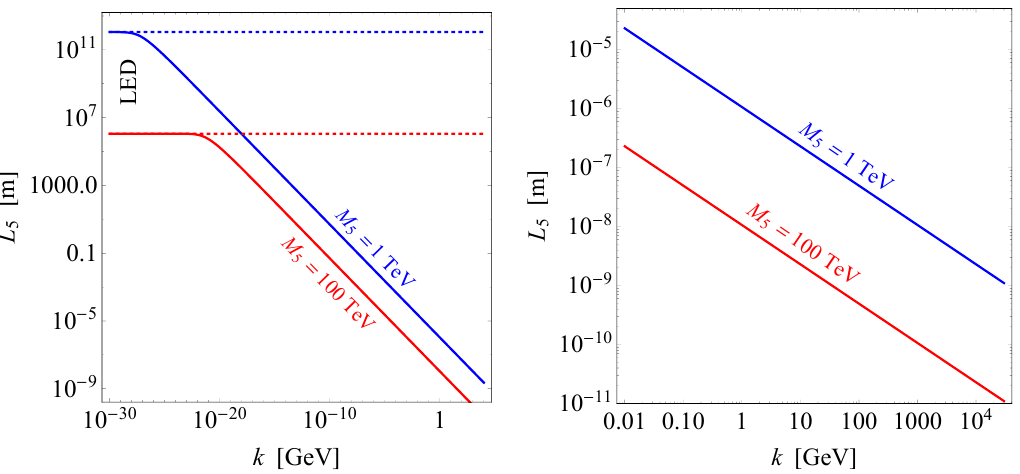
Figure 1 . The required physical size of the extra dimension as a function of k for M 5 = 1 TeV (blue) and 100 TeV (red). The horizontal dotted lines indicate the LED limit. The plot on the right zooms in on the phenomenologically most relevant range of k